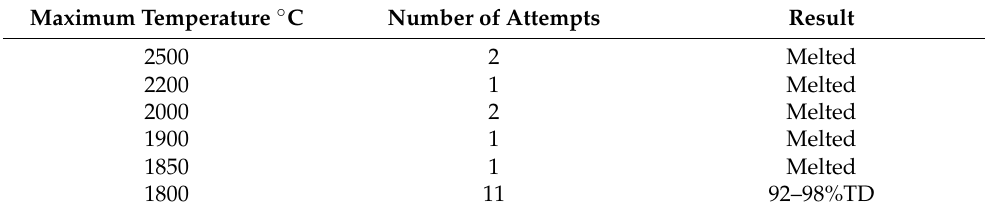
Figure 3. Measured temperature profile for CeN sintering. The dwell time at 1800 °C is approxi- mately 30 s. Temperature below 700 °C is estimated as they are outside the measurement range. See supplementary Data S1. Table 1. Samples tested at various maximum temperatures in this study. Table 1. Samples tested at various maximum temperatures in this study.